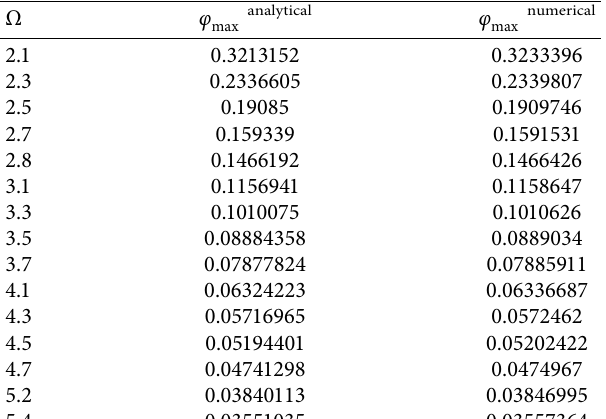
Table 2: φ of the second case ( ] � 1 , μ � 5000 ) . max